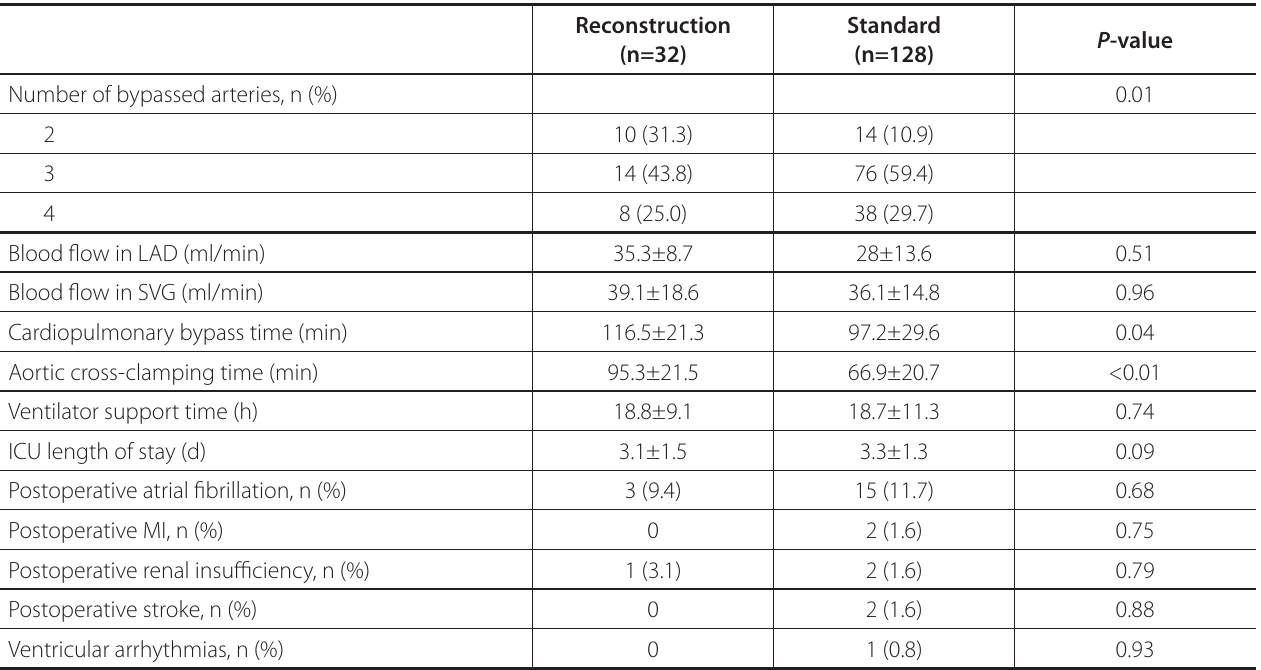
Table 2 . Intraoperative and postoperative